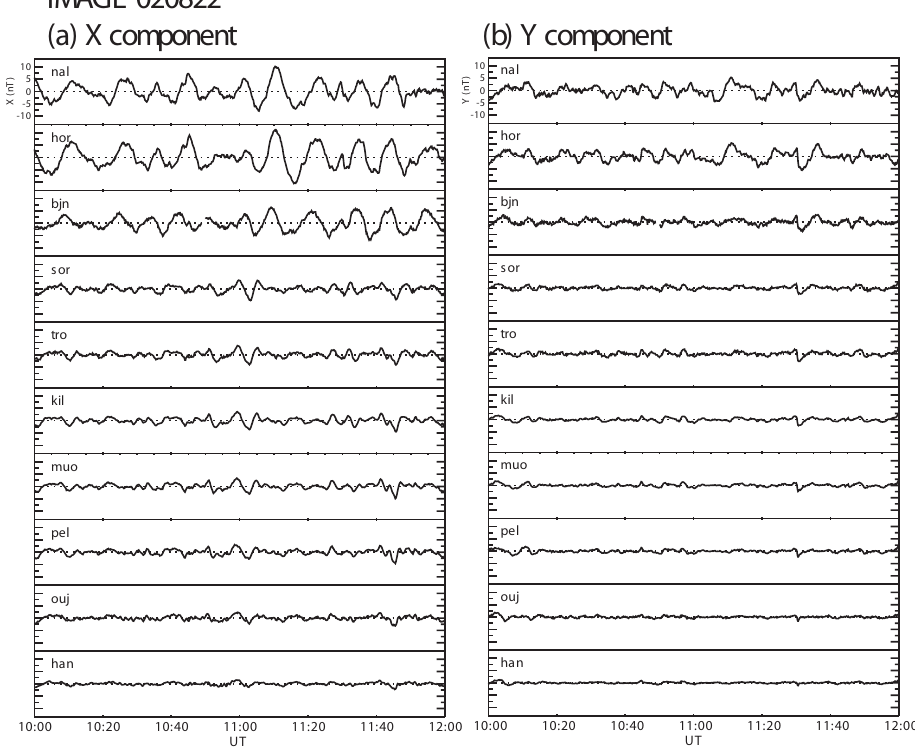
Fig. 10. ( a ) the X component and ( b ) the Y -component, IMAGE magnetometer data on 22 August 2002 for 10:00–12:00 UT, bandpass filtered between